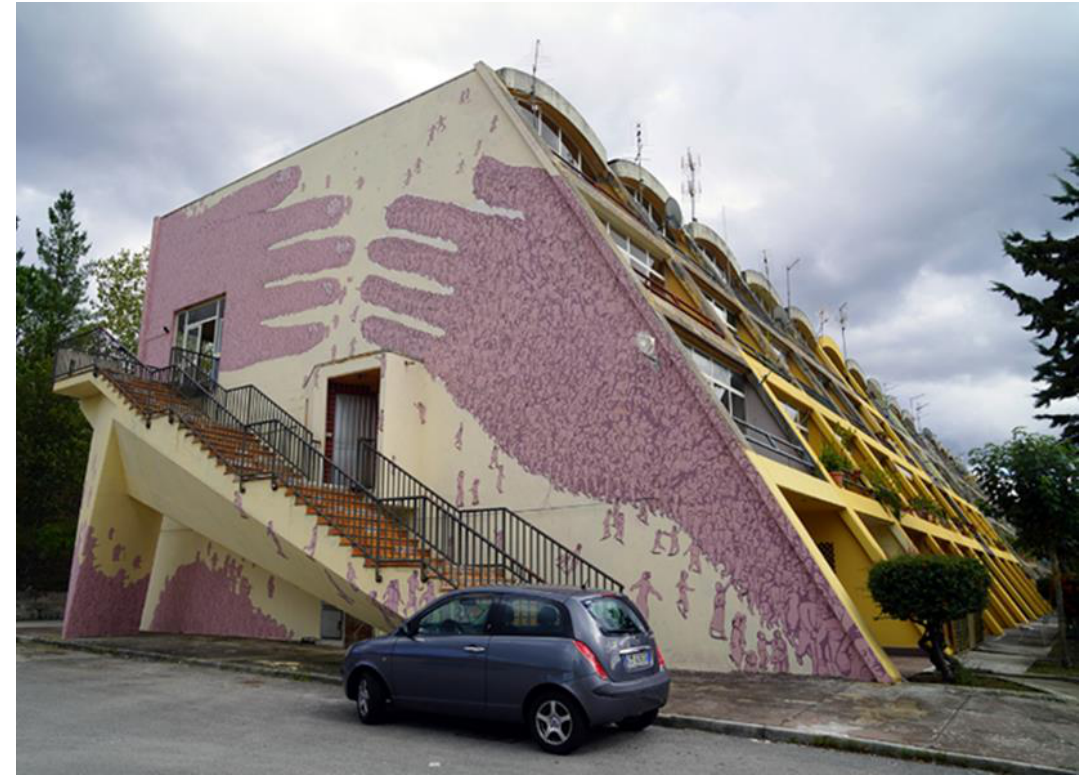
Figure 24. Lioni: a detail of the “Bergamo condominium”, the recent murales was done to remember the solidarity of the people forty years after the catastrophic earthquake (photos by [35,36]).